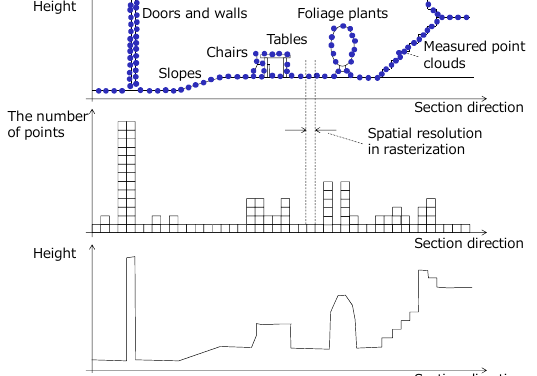
Figure 3. Floor map generation (outline extraction and missing area interpolation in point clouds)